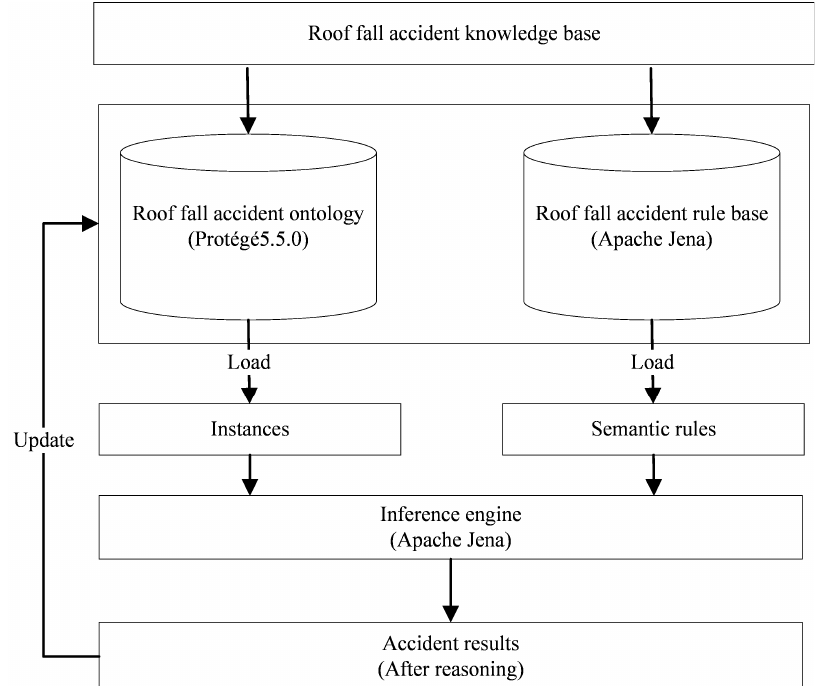
Figure 10. The system architecture of roof fall accident knowledge base.